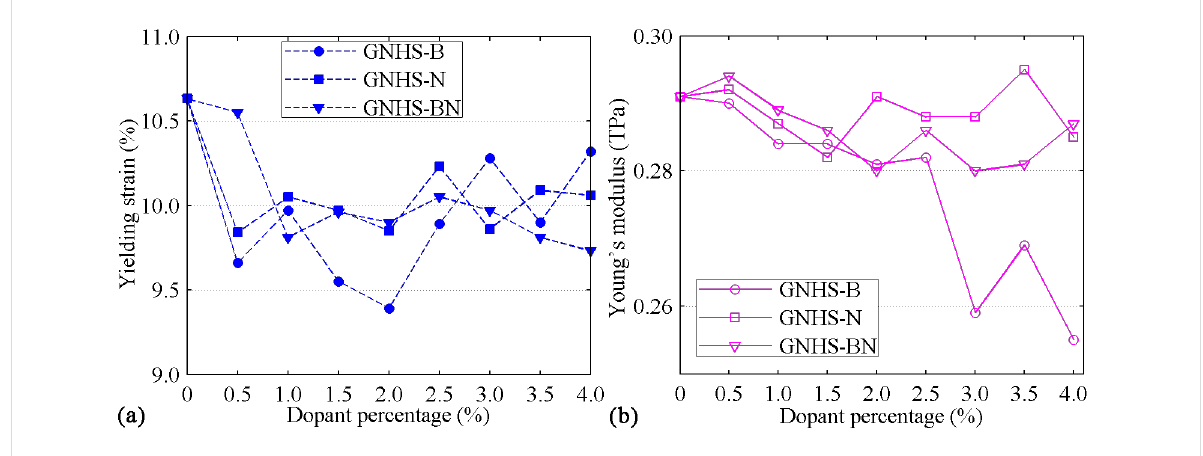
Figure 9: Yield strain, YP , and Young’s modulus, E , as a function of the concentration of N-, B-, and